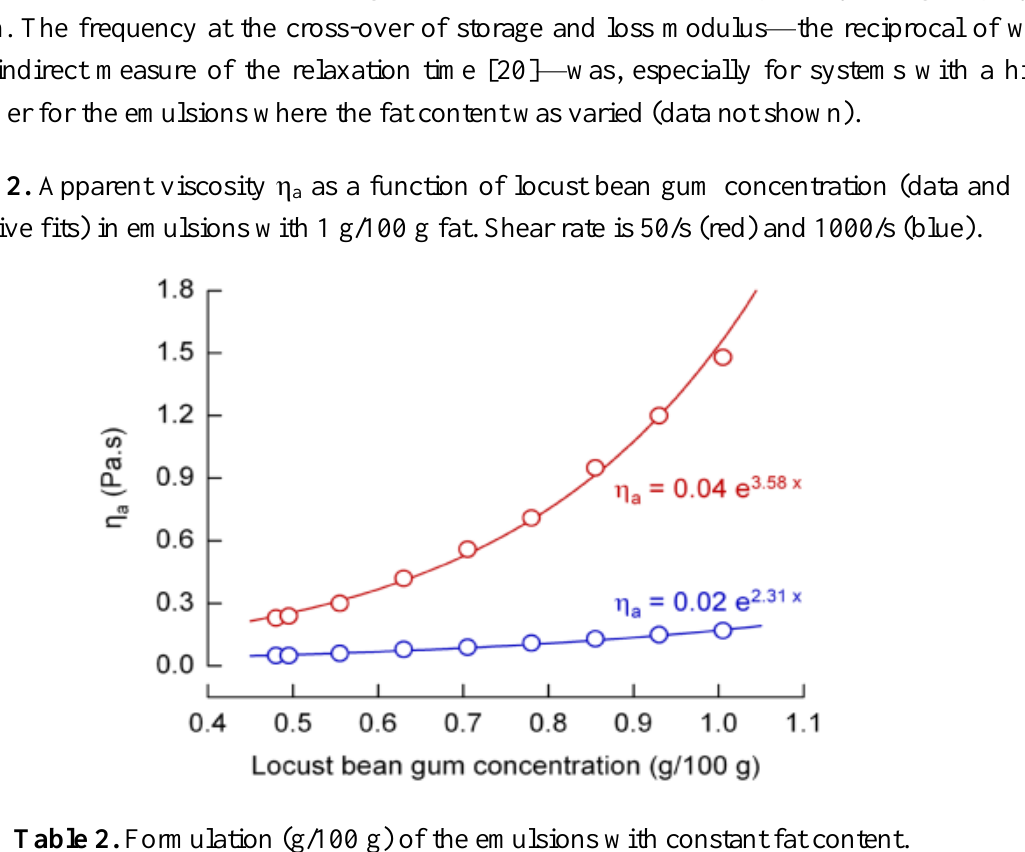
Table 2. Formulation (g/100 g) of the emulsions with constant fat